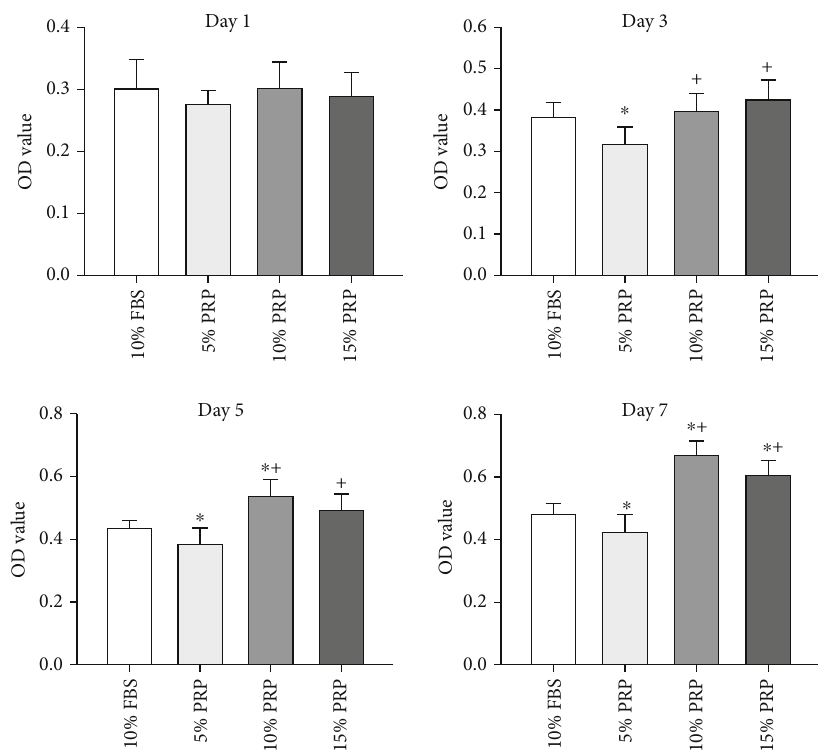
Figure 3: Cell counting assay for BMSC proliferation in the di ff erent medium. ∗ P < 0 : 05 compared to 10% FBS group, + P < 0 : 05 compared to 5% PRP group. OD: optical density; FBS: fetal bovine serum; PRP: platelet-rich plasma.